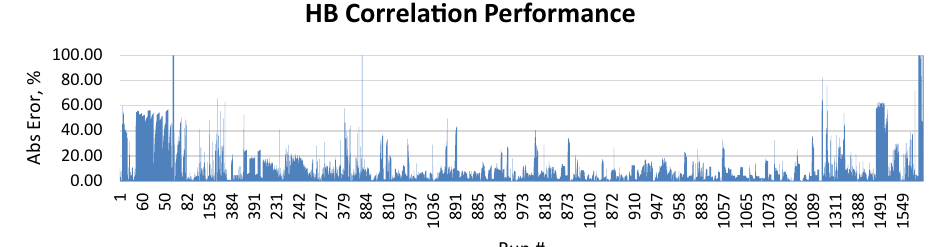
Fig. 1 Hagedorn and Brown correlation performance through the entire database